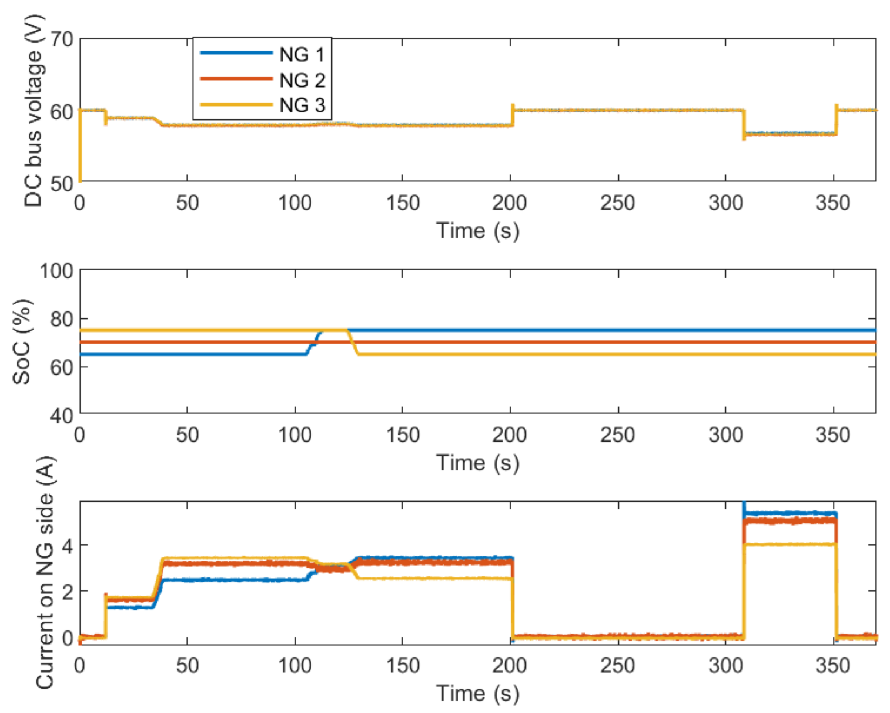
Figure 24. Impact of a communal load on the microgrid power